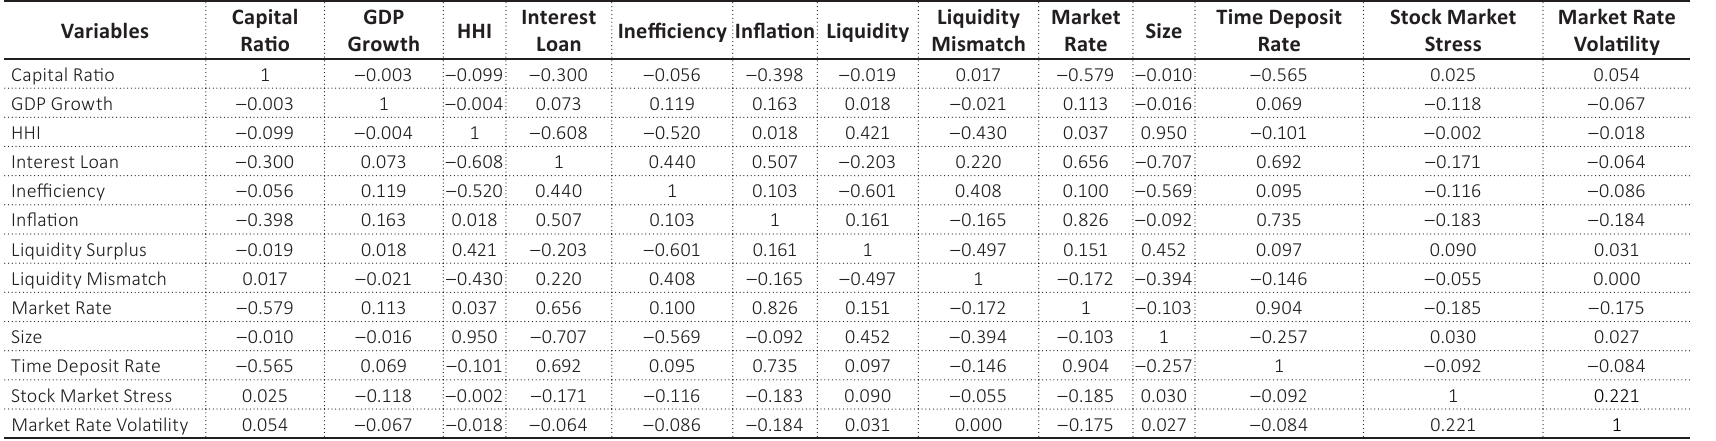
Table D2. Correlation within variables from equation 3 (Time Deposit Rate –